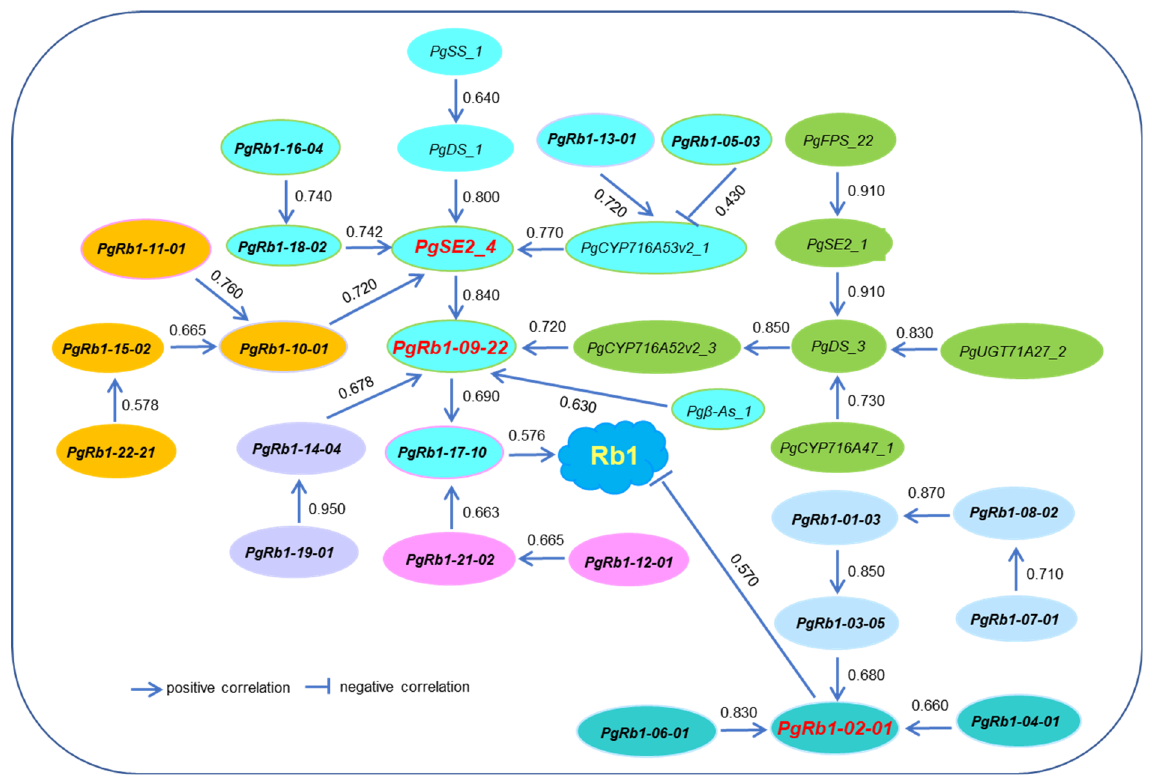
Figure 5. The putative pathway of 32 Rb1 biosynthesis genes in Rb1 biosynthesis. The pathway was de- termined by the correlations of their expressions in four-year-old plant roots of 42 cultivars at a cutoff p - value ≤ 0.01, assuming that the genes directly interacting with each other have higher expression correla- tions than those indirectly interacting. The correlation coefficients are shown between the genes. The genes highlighted with different colors indicate different interaction groups of the genes. The genes with bold font indicate the new PgRb1 genes identified in this study and the remaining genes are the Rb1 biosynthesis genes previously cloned (Table S3). The genes in red bold font indicate the hub genes in the network. The arrow or “T” sign direction of the gene action is drawn based on its pathway toward